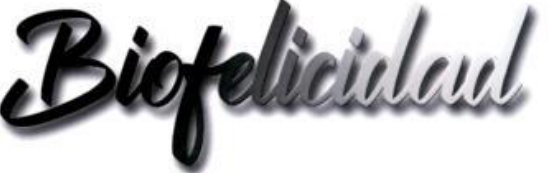
Figure 3. Biofelicidad brand.